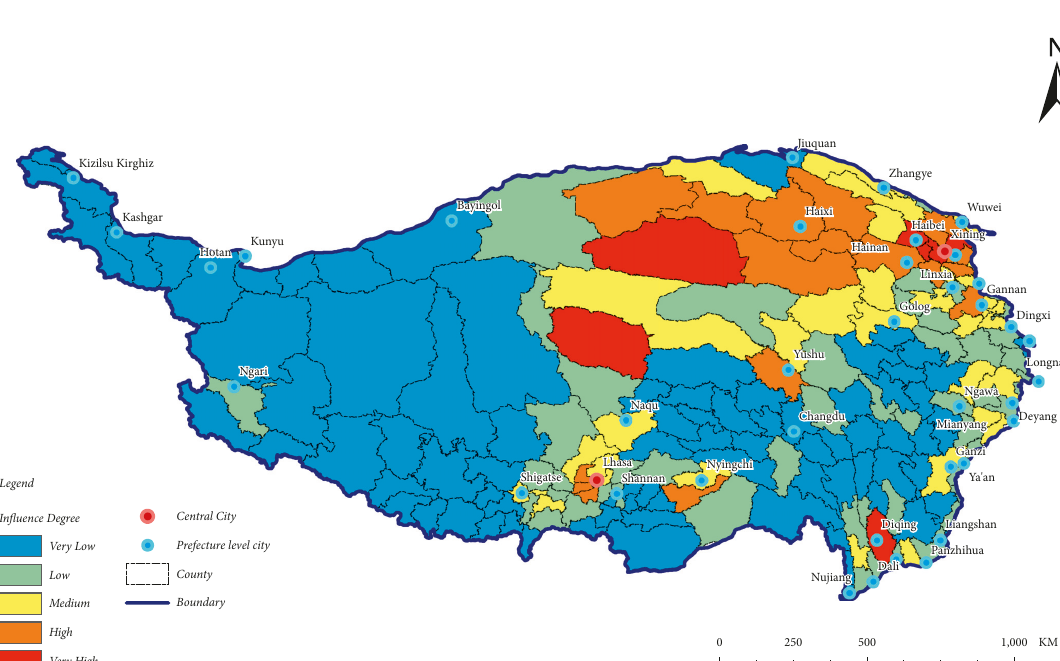
Figure 9: Local spatial autocorrelation of NLDI .